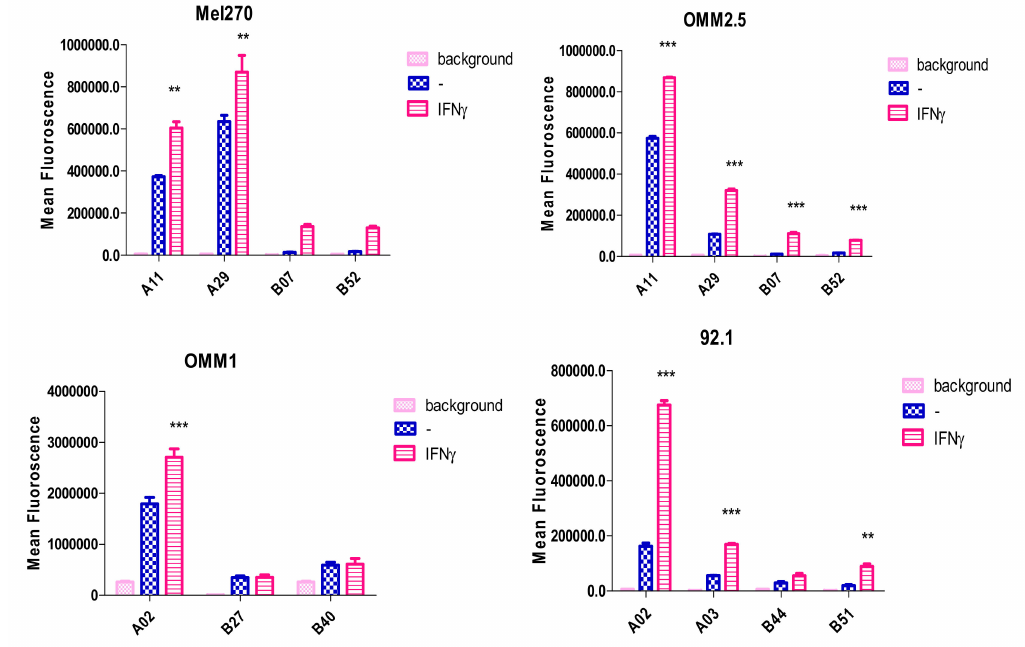
Figure 2. HLA-typed Uveal melanoma (UM) cell lines can be analysed by Fluorescence-Activated Cell Sorting (FACS) using HLA antigen specific monoclonal antibodies to find defects in the expression of HLA alleles, and to determine the sensitivity of induction by Interferon gamma (IFN γ ). Loss of HLA Class I allele expression in UM cell lines: B7 and B52 loss in Mel270, B27 and B40 loss in OMM1, B44 loss in 92.1. (** p = 0.01; *** p =